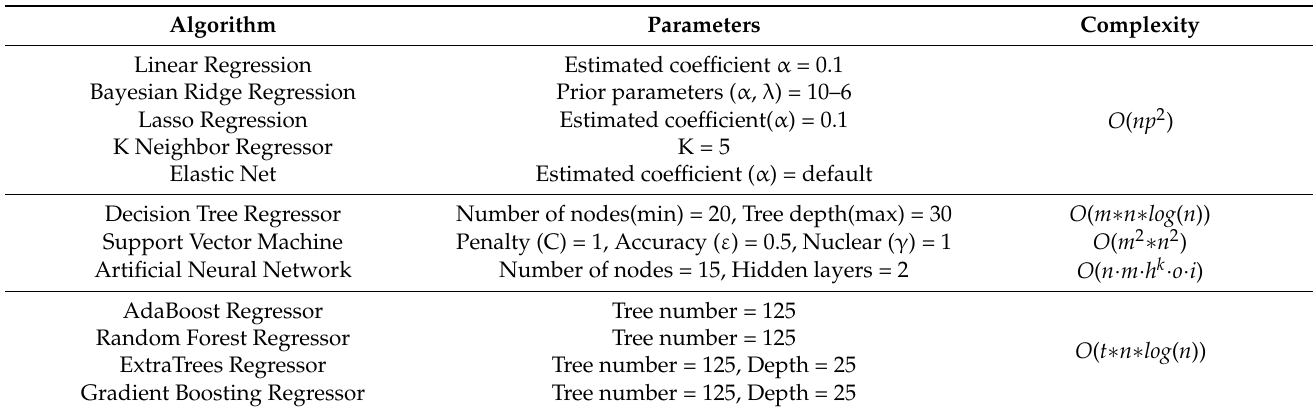
Table 1. The main parameters and complexity of machine learning algorithms.